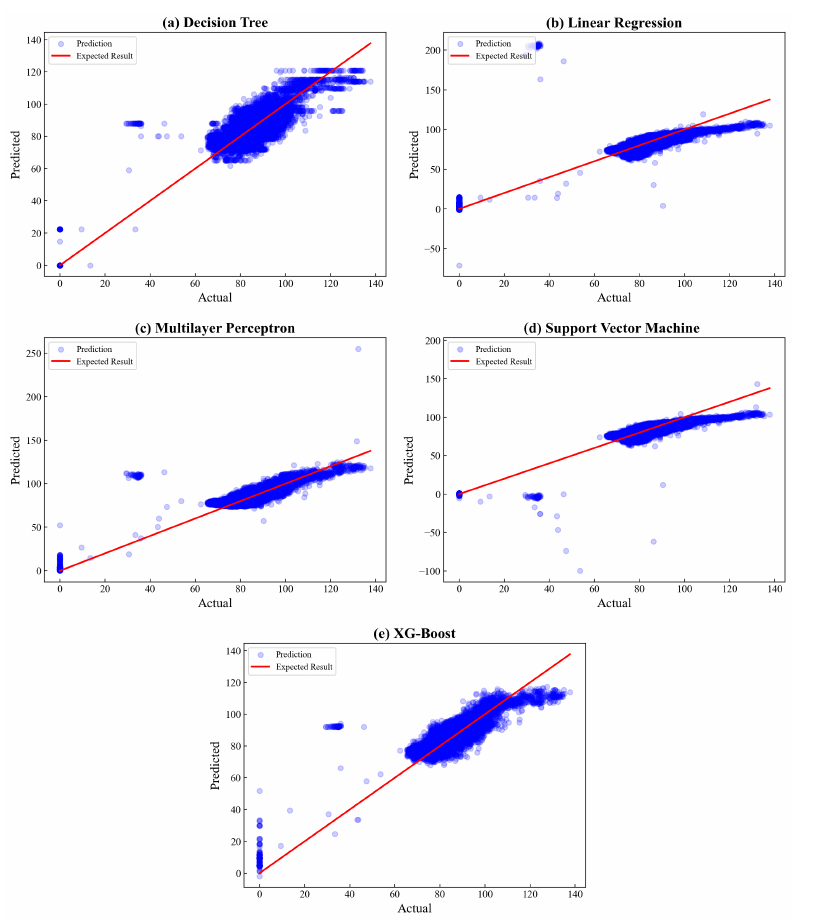
Figure 13. Actual vs. predicted plot of NO x